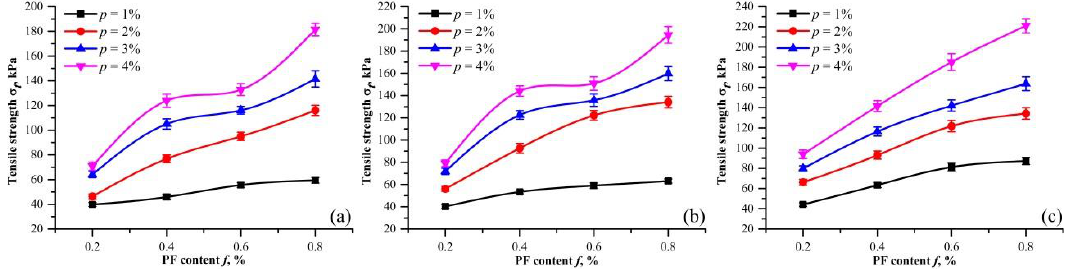
Figure 7. Tensile strength of specimens with different PF content at different dry density: ( a ) 1.40 g/cm 3 ; ( b ) 1.50 g/cm 3 ; ( c ) 1.60 g/cm 3 ( t = 48 h, and the bars are standard deviations).